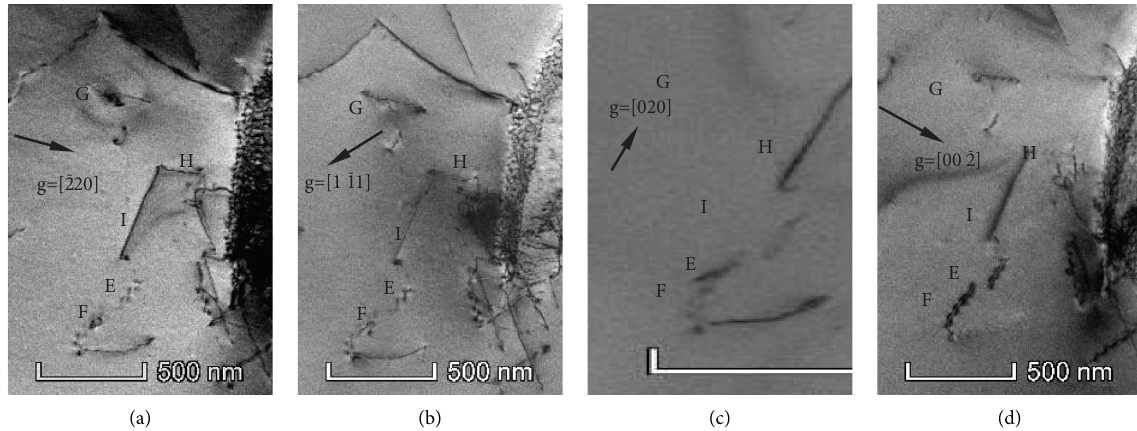
Figure 7: Dislocation confguration after creep fracture at 1040 ° C/137MPa: (a) g � [ ‾ 220 ] , (b) g � [ 1 ‾ 11 ] , (c) g � [ 020 ] , and (d) g � [ 00 ‾ 2 ]